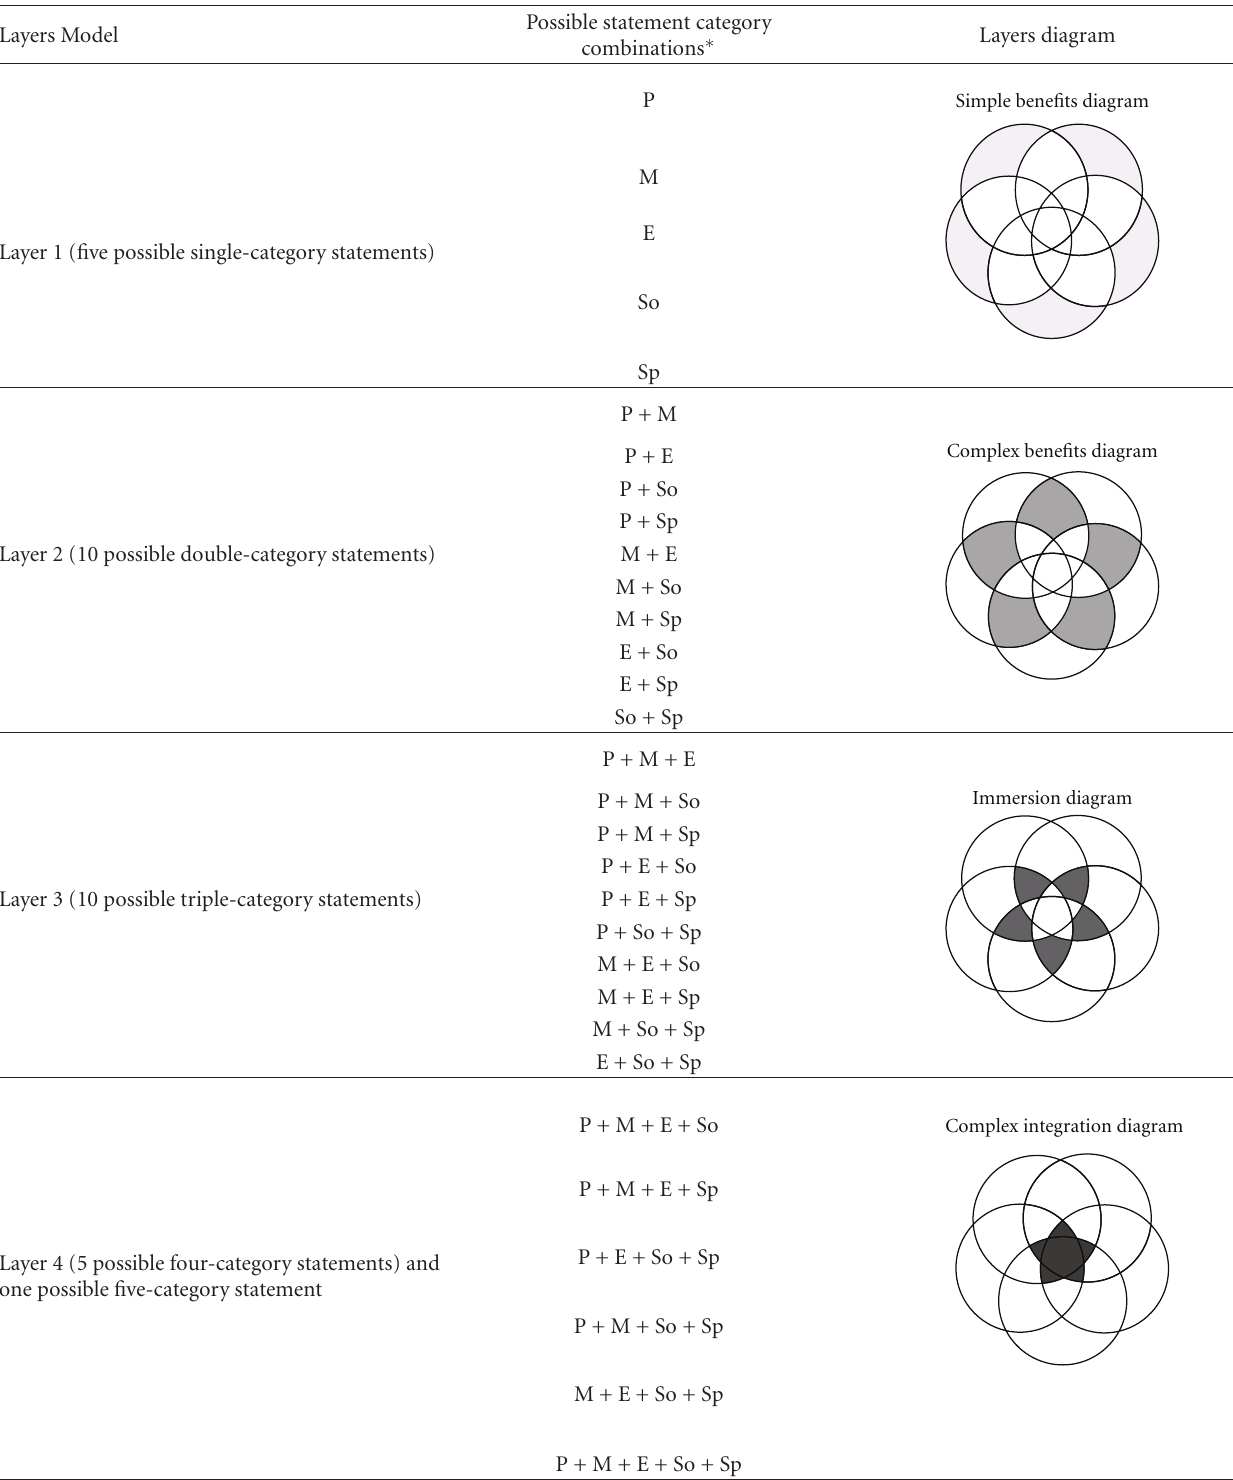
Table 1: Layers diagram, Layers Model, possible category